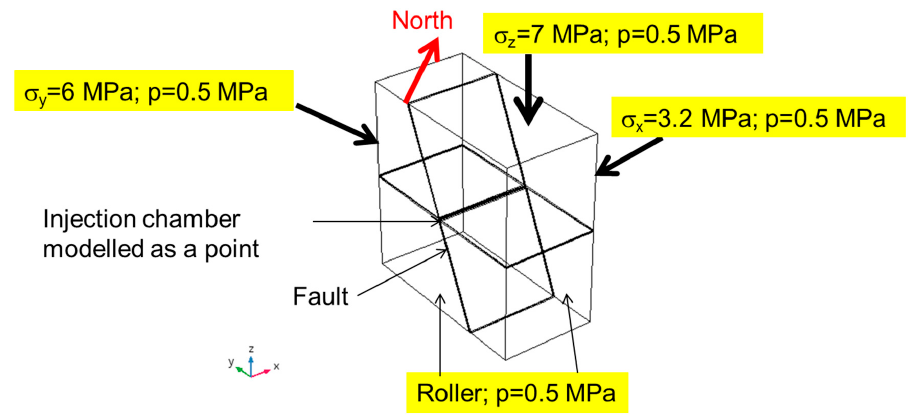
Figure 3. Numerical model and boundary conditions for water injection in secondary fault. The model dimensions are 10 m × 20 m × 20 m.